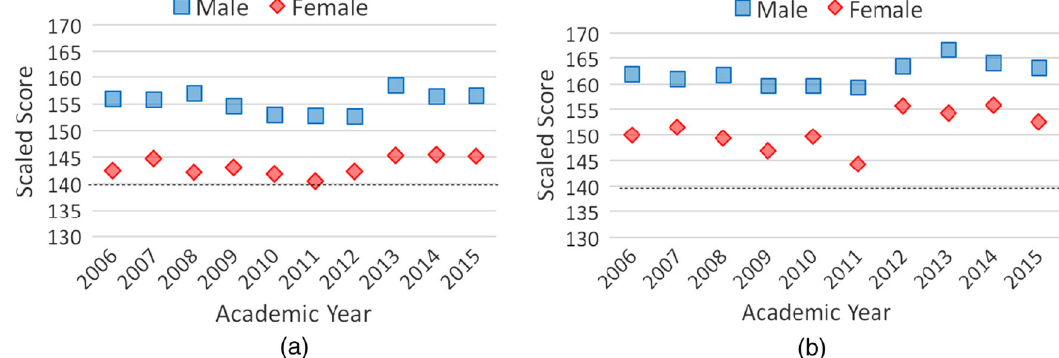
FIG. 3. Praxis physics subject assessment performance by (a) all examinees ’ reported gender and (b) the indicated gender of examinees reporting physics and engineering undergraduate majors. Scaled score is plotted against academic year (i.e., academic year 2015 ¼ June 2015 – May 2016 ). Dashed line represents the median passing score of 140 across states. Source: Derived from data provided by the Educational Testing Service.